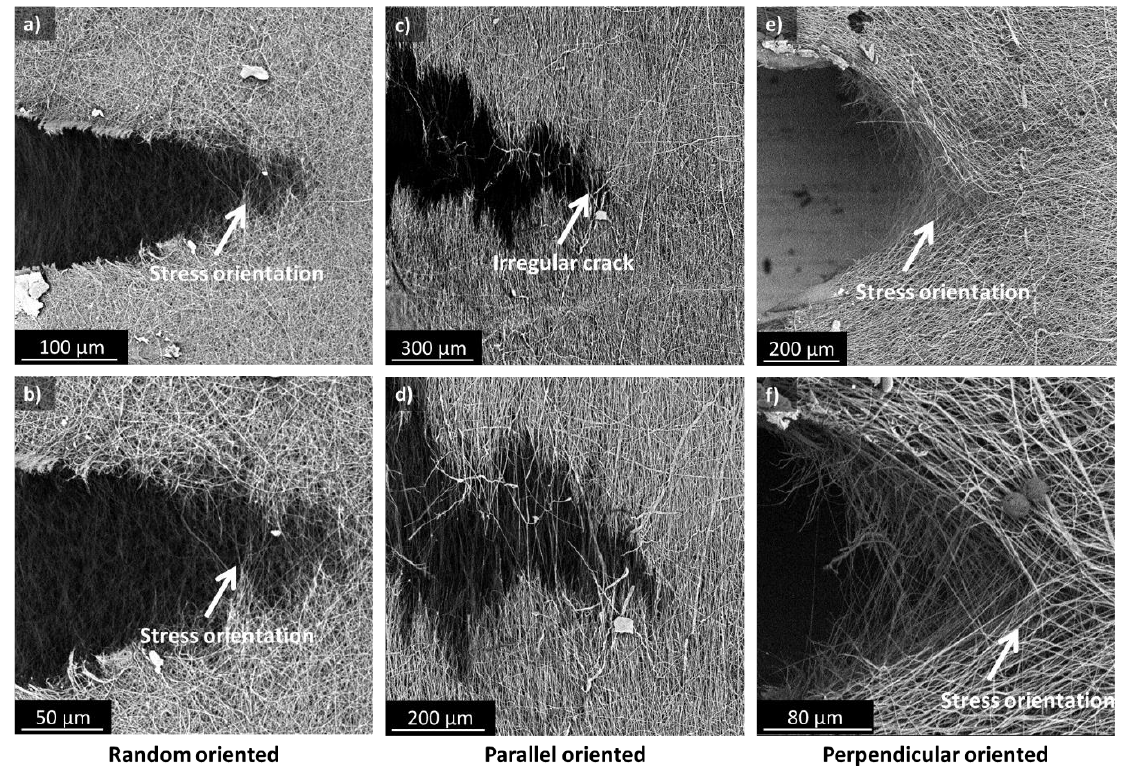
Figure 7. In situ SEM observations at the crack tip for random ( a , b ), parallel ( c , d ), and perpendicular oriented nanofiber membranes ( e , f ).